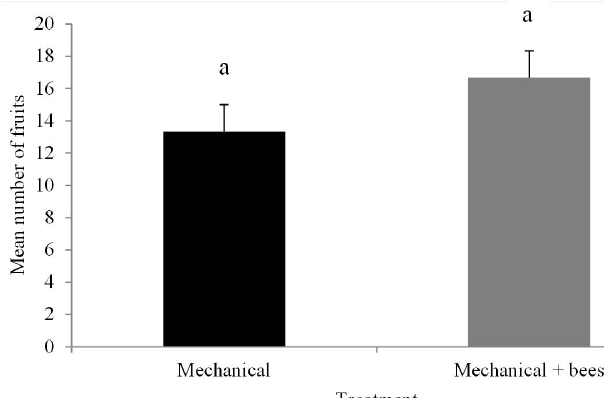
Fig 1 . Mean number (± standard error) of fruit set per branch in the two greenhouses of grape tomato, one control (mechanical method of pollination alone) and the other where Melipona quadrifasciata bees were introduced (pollination by mechanical method + pollination by bees), in Araguari, Minas Gerais state, Brazil. The same letters indicate no significant difference between Table 2 . Mean values (± standard deviation) of each of the parameters related to fruit quality in the two different treatments (mechanical method of pollination alone and pollination by mechanical method + pollination by bees), in Araguari, Minas Gerais state, Brazil.